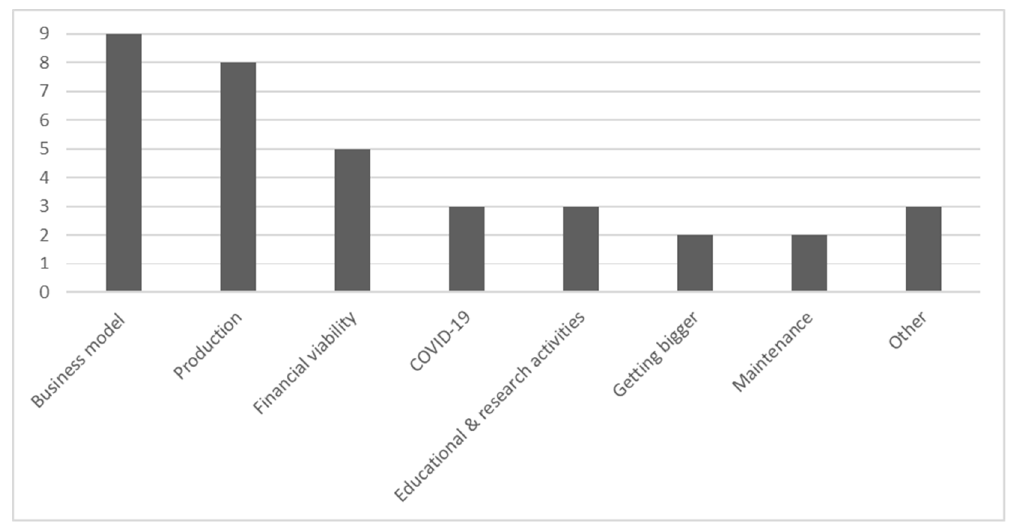
Figure 14. Number of respondents for the different challenge categories.